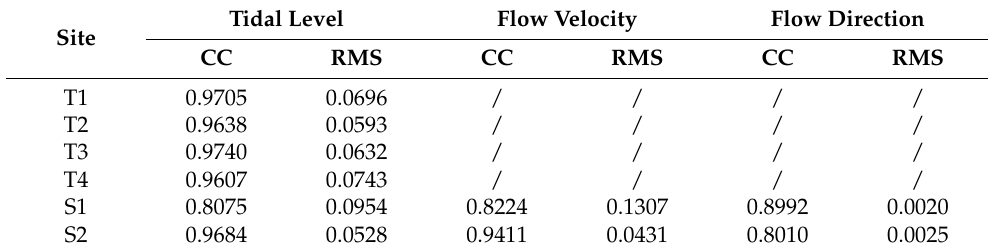
Table 1. CC and RMS between observational data and model results.